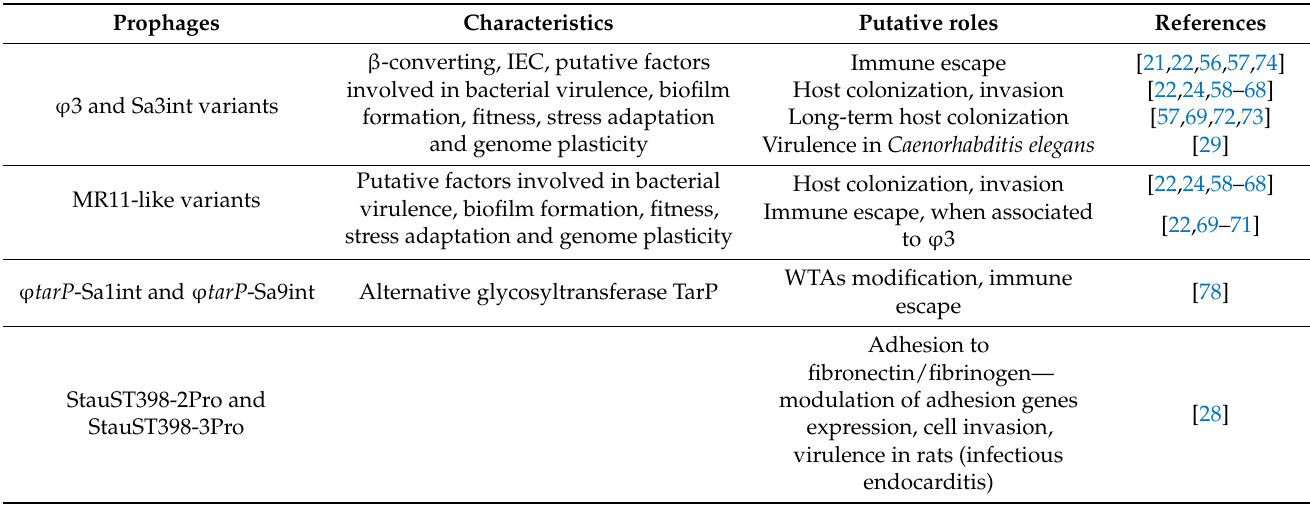
Table 1. Roles of the main CC398-borne prophages in bacterial virulence.